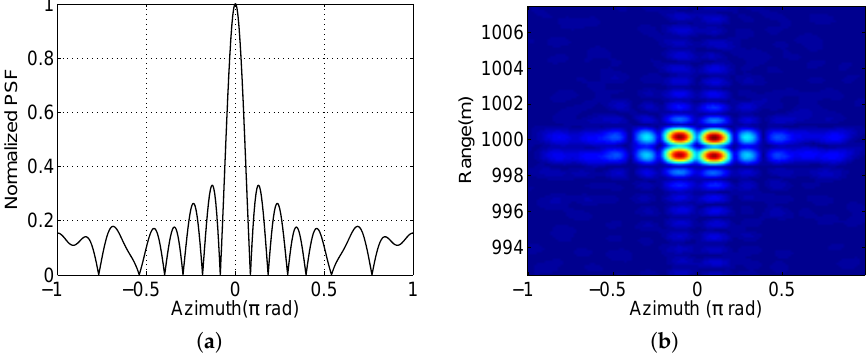
Figure 4. ( a ) The azimuth profile of the PSF of Figure 3b after phase compensation; ( b ) Two-dimensional imaging results of four ideal scatterers whose range and azimuth interval are 1 m and 0.2 π , respectively. The signal bandwidth and OAM mode range are 200 MHz and [ − 7,7 ] , respectively. The array radius is 5 λ and the elements number is N =